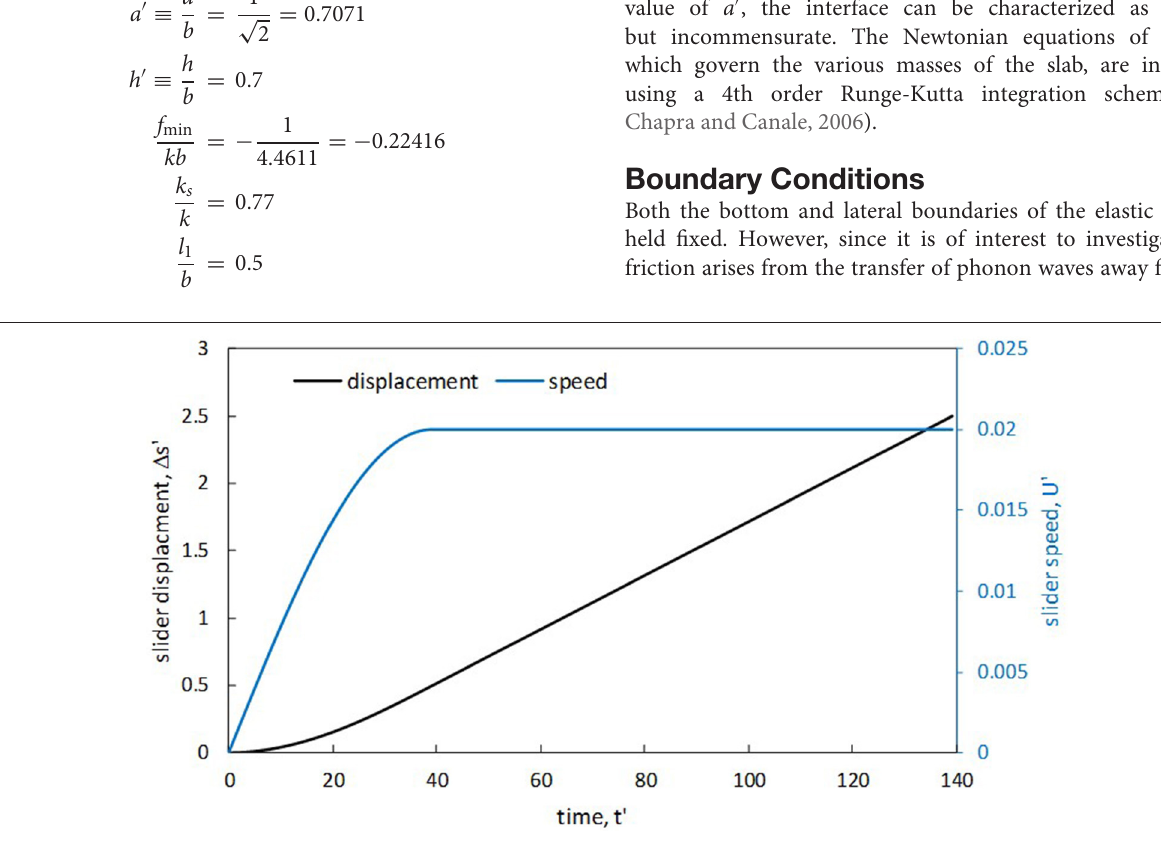
FIGURE 2 | Prescribed time histories of slider displacement and velocity for the various simulations.